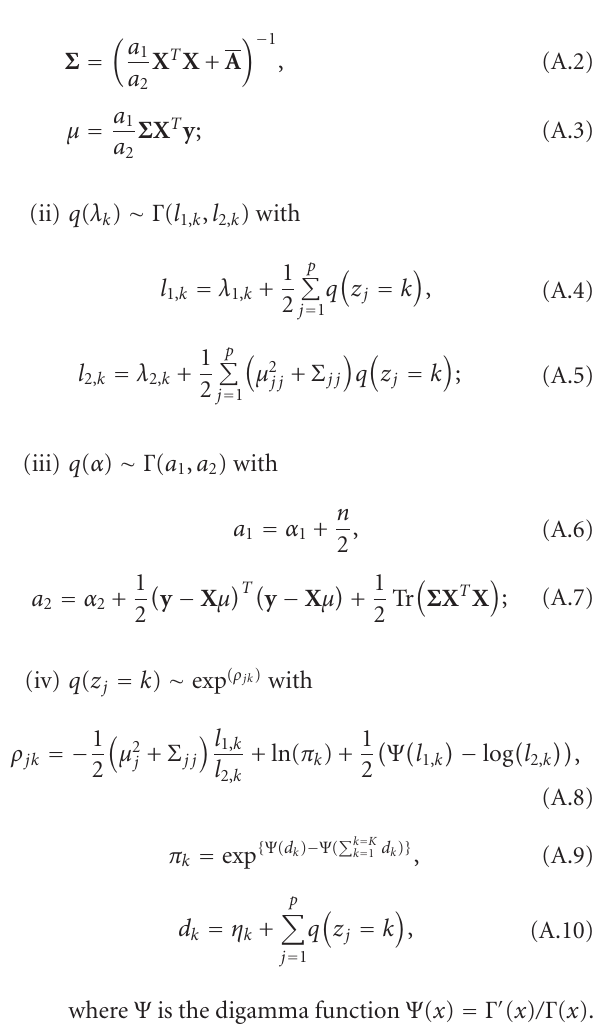
Algorithm 2: Gibbs-MCBR